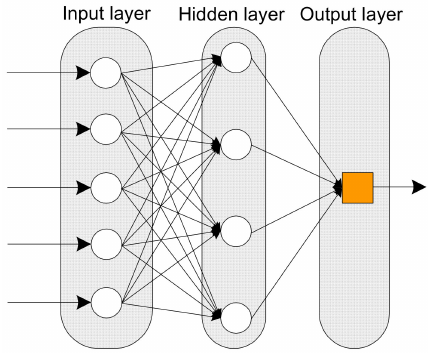
Figure 6. Conceptual diagram of an artificial neural network (ANN)